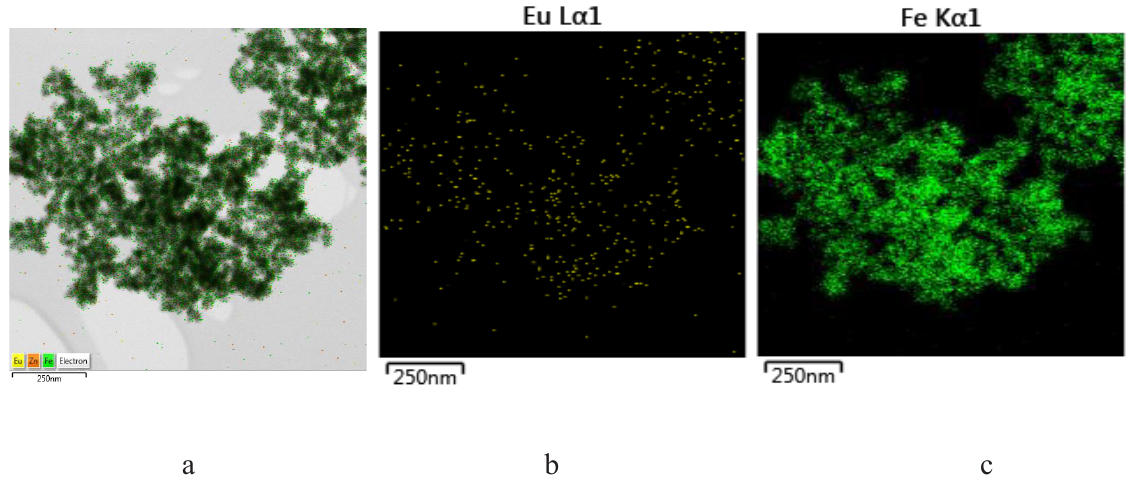
Figure 3: Elemental mapping of the sample ZNF-Eu1 (a). The equal distribution of Eu(III) on the surface is shown (b) and for comparison, the distribution of Fe(III) (c).